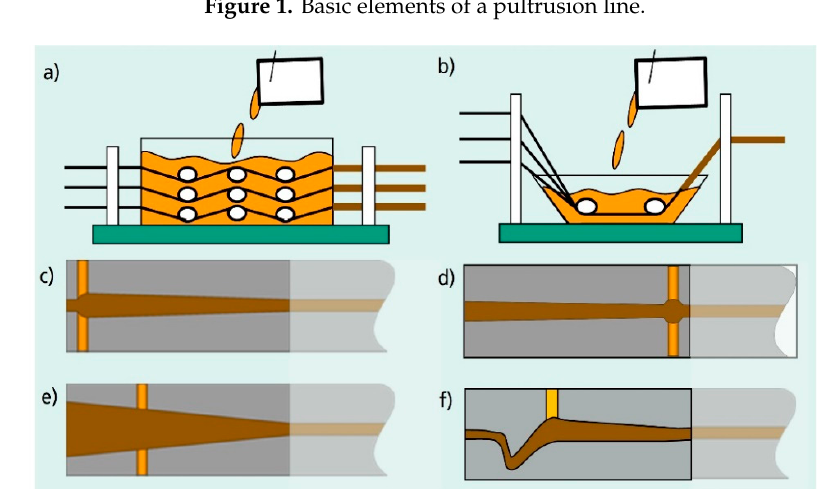
Figure 1. Basic elements of a pultrusion line.